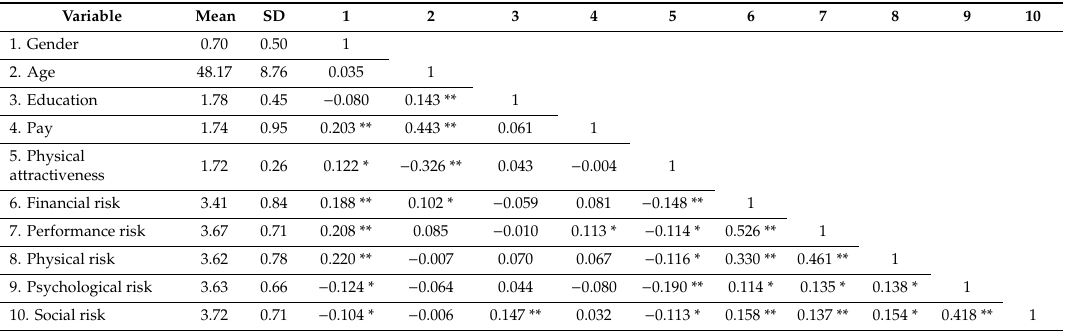
Table 3. Correlation of all variables (N =